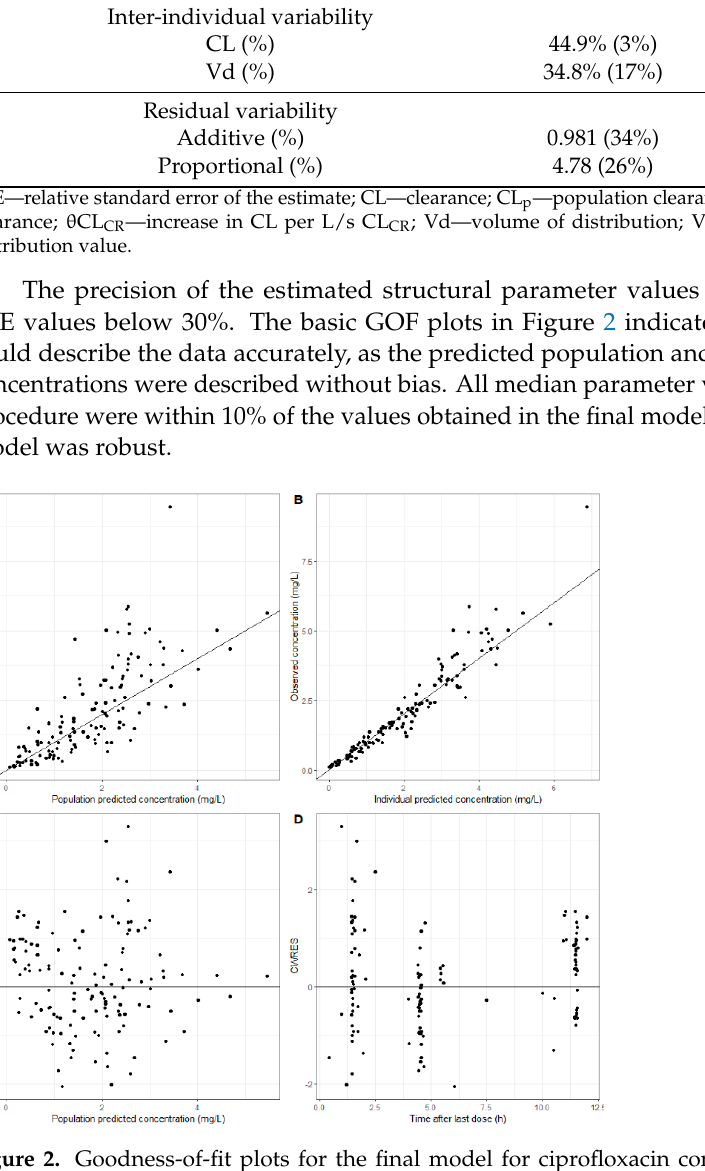
Figure 3. Visual output of the normalized prediction distribution error (NPDE) analysis. Shown at the top are the QQ plot and histogram of the NPDEs in the overall dataset. The red dotted line and blue shaded areas show the expected trends and 95% confidence intervals of these trends, while the dark blue lines and bars show the observed NPDE distributions. At the bottom, the individual NPDE values for each observation are plotted versus time and versus the predicted concentrations with the symbols. The solid lines in the bottom graphs indicate the mean (red) and the 95% percen- tiles (blue) of the NPDEs, and the shaded areas are the simulated 95% confidence intervals of the NPDE median (red) and 95% percentiles (blue), while the dotted red and blue lines show the ex- pected values for the median and 95% percentiles.